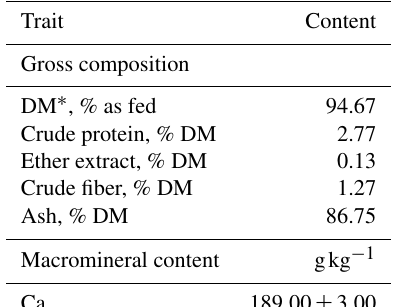
Table 1. Gross composition (mean) and detailed macromineral and micromineral (mean ± standard deviation) characterization of the tested commercial